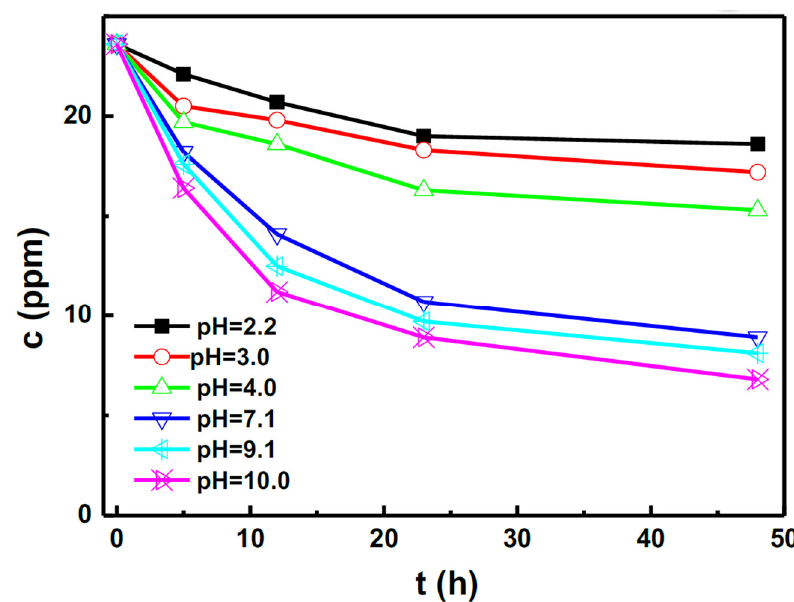
Figure 6. The residual hexadecyl trimethyl ammonium bromide (CTAB) after sorption as a function of pH.